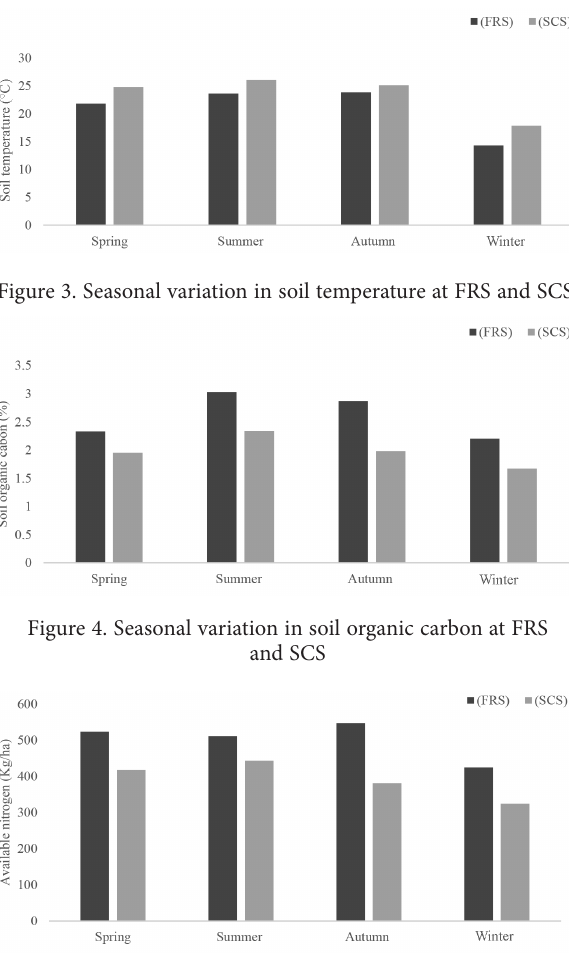
Figure 5. Seasonal variation in soil available nitrogen at FRS and